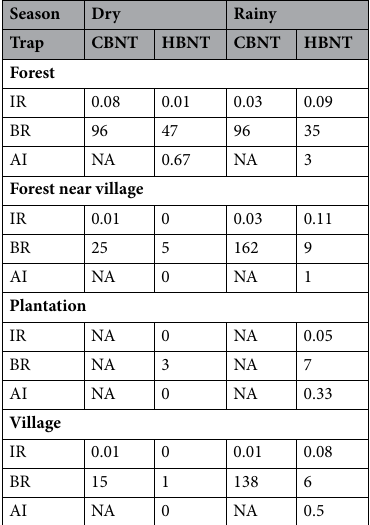
Table 1. Biting and infectious rates of Anopheles mosquitoes collected by HBNTs and CBNTs across sites and seasons. IR = infection rate (number of infectious mosquitoes/total number of mosquitoes), BR = average biting rate per trap per day, AI = average number of infectious bites per day (IRxBR). NA = non